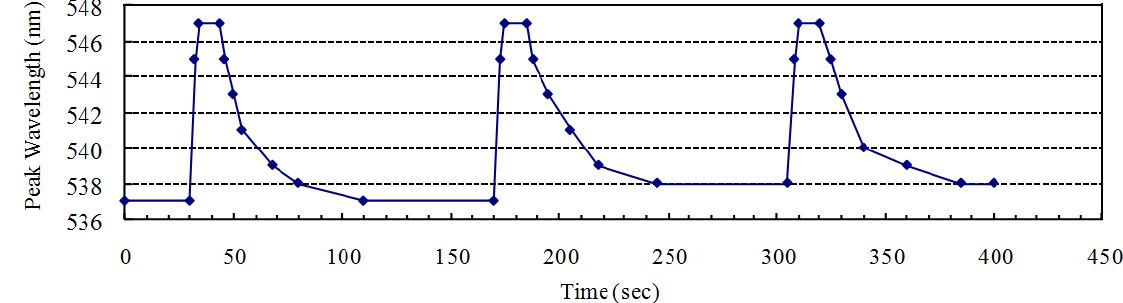
Figure 4. Time responds to saturated ethanol vapor of the